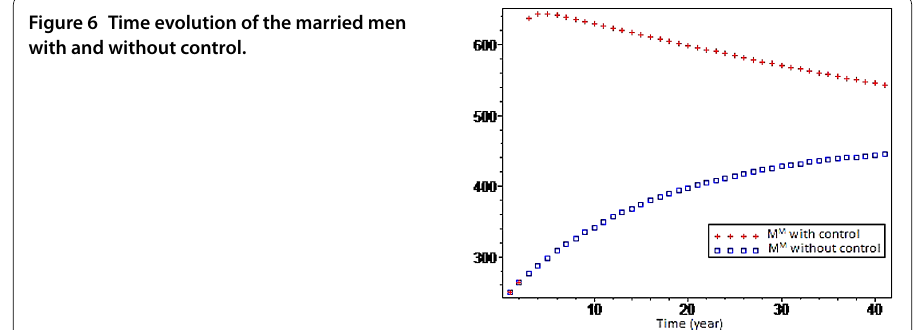
Figure 6 Time evolution of the married men with and without control.